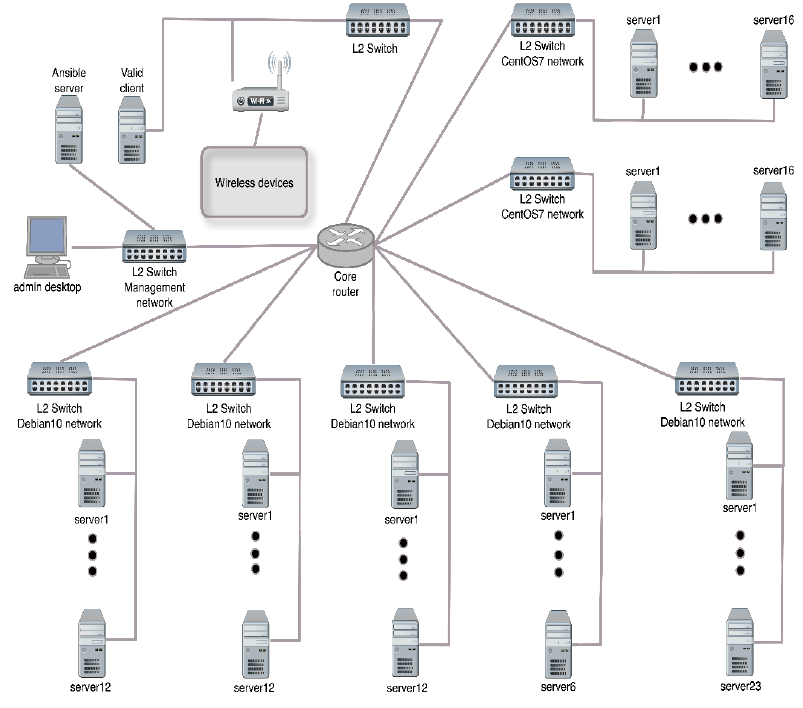
Figure 5. Structure of Ansible real-time attack environment for DDoS experimentation.